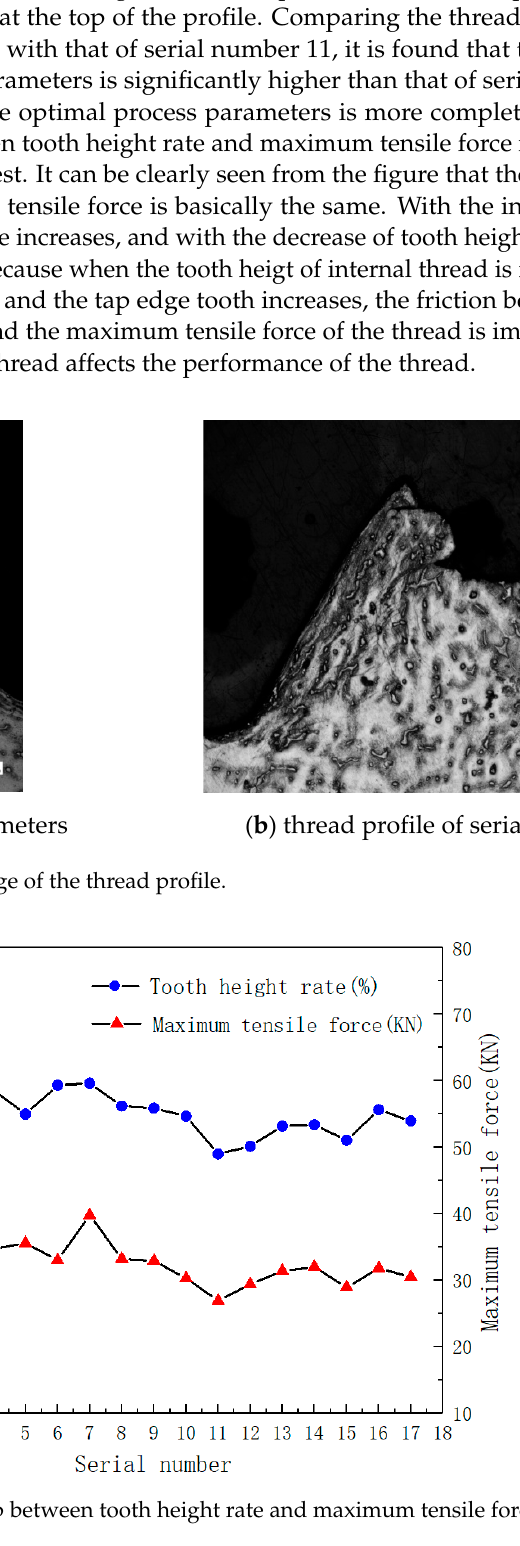
Figure 8. Relationship between tooth height rate and maximum tensile force.